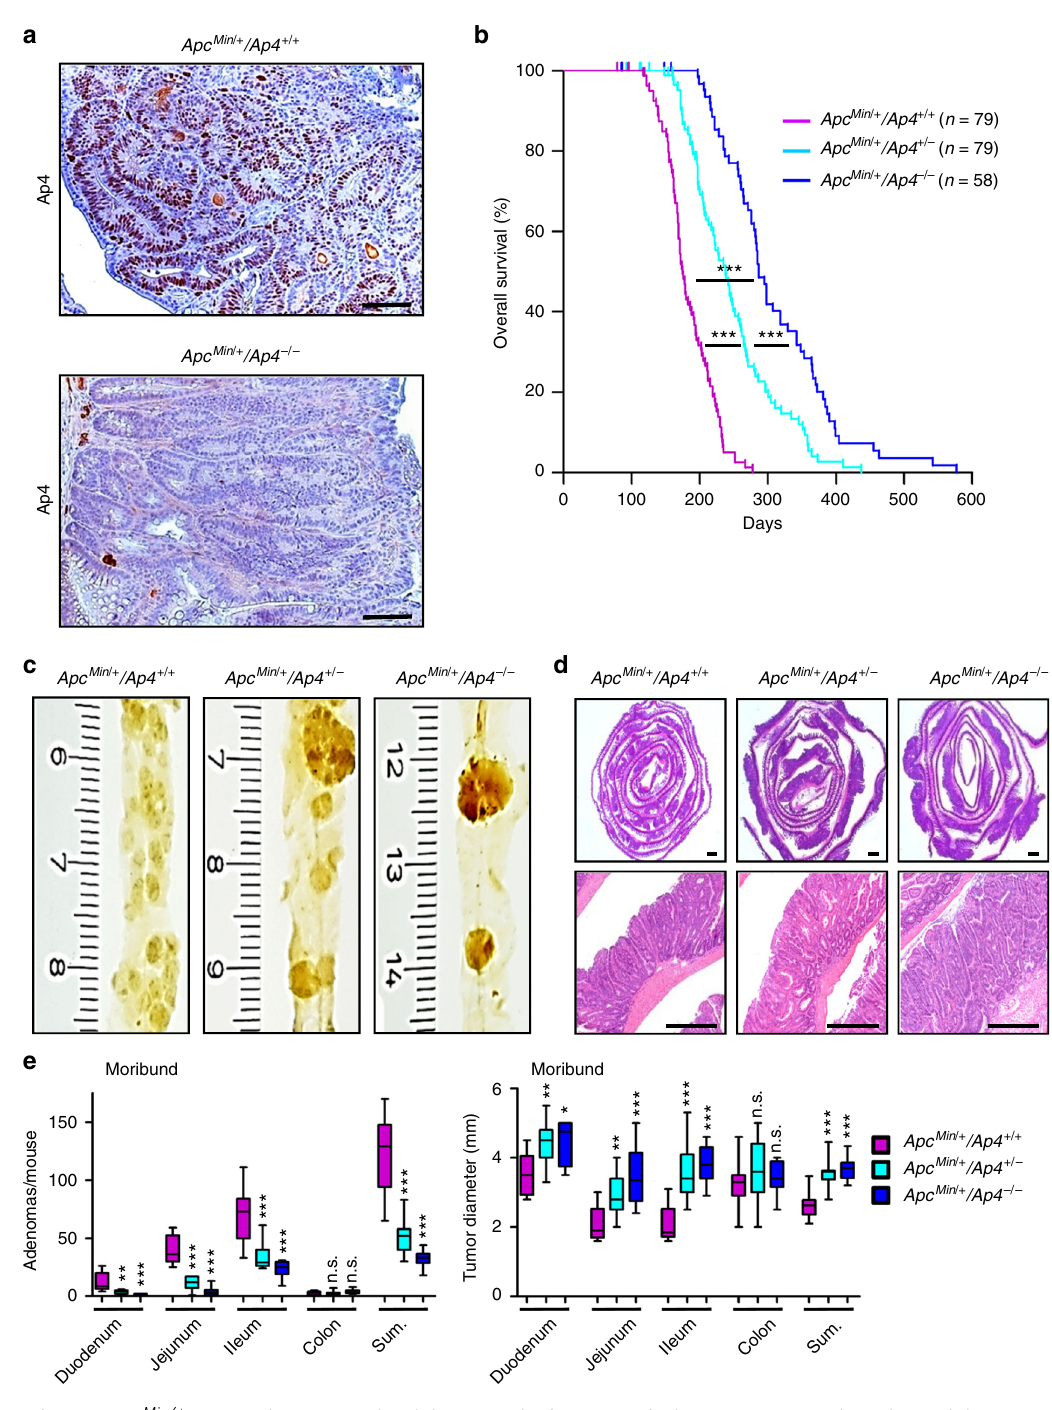
Fig. 1 Deletion of Ap4 in Apc Min/ + mice prolongs survival and decreases the frequency of adenomas. a Immunohistochemical detection of Ap4 in adenomas of moribund Apc Min/ + mice with the indicated genotype. Counterstaining with hematoxylin. Scale bar = 50 µ m. b Kaplan – Meier survival analysis of Apc Min/ + mice with the indicated genotypes. Censored mice without intestinal tumor-related death are indicated on the Kaplan – Meier curve as tick marks. c Macroscopic pathology of representative polyps in the small intestine (ileum) of moribund Apc Min/ + mice with the indicated genotype, scale in cm. d Representative sections through rolls of the small intestine stained for hematoxylin and eosin (HE). Scale bar = 500 µ m. e Quanti fi cation of adenoma number/mouse (left panel) and tumor diameter (right panel) in the intestine of six male and six female ( Apc Min/ + /Ap4 + / + ), fi ve male and fi ve female ( Apc Min/ + /Ap4 + /- ) or four male and four female ( Apc Min/ + /Ap4 -/- ) moribund Apc Min/ + mice. The box plot extends from the 25th to 75th percentiles. The line in the middle of the box is plotted at the median. The whiskers underneath or above the boxes range from min. to max. value, respectively. b Results were subjected to a log-rank test with p -values * < 0.05, ** < 0.01, *** < 0.001, n.s. not signi fi cant. e Results represent the mean ± SD. Results were subjected to an unpaired, two-tailed Student ’ s t -test with p -values * < 0.05, ** < 0.01, *** < 0.001, n.s. not signi fi cant. See also Supplementary Fig.